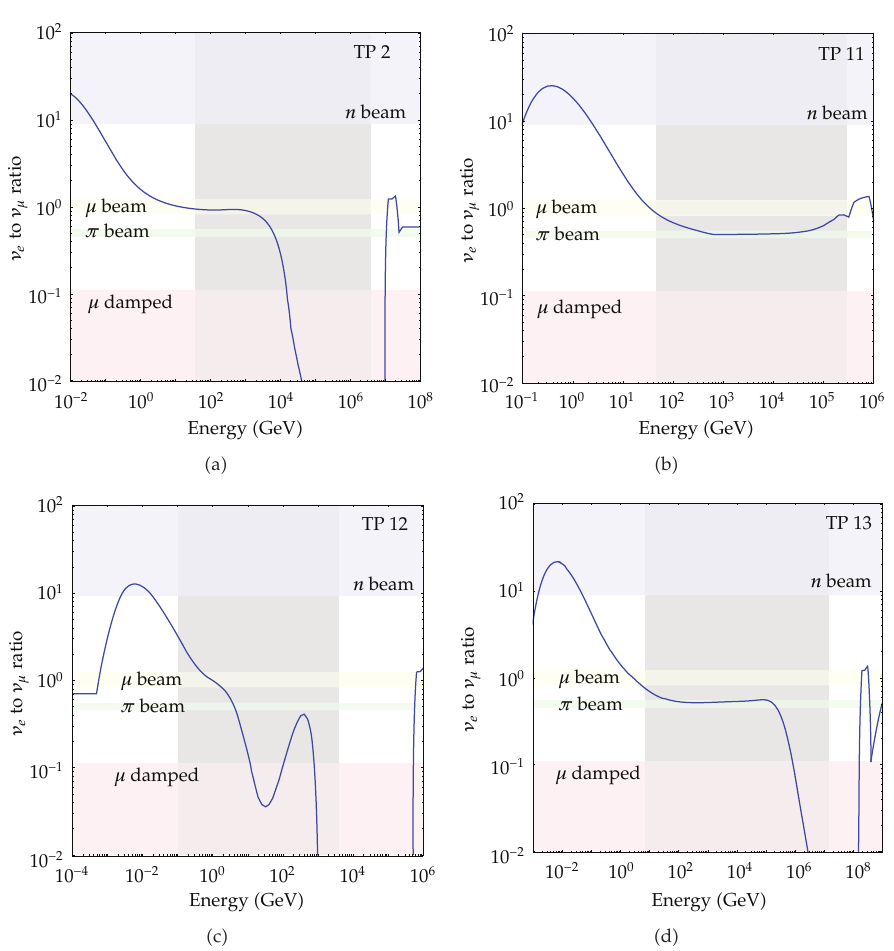
Figure 5: Energy-dependent flavor ratio at the source for several selected parameter sets (cid:3) test points “TP”; cf. Figure 10 (cid:4) for a model where N (cid:3) γ is generated by synchrotron losses of coaccelerated electrons. The (cid:3) dark (cid:4) gray-shaded areas mark the regions where the fluxes peak, figure taken from (cid:5) 34 (cid:6)